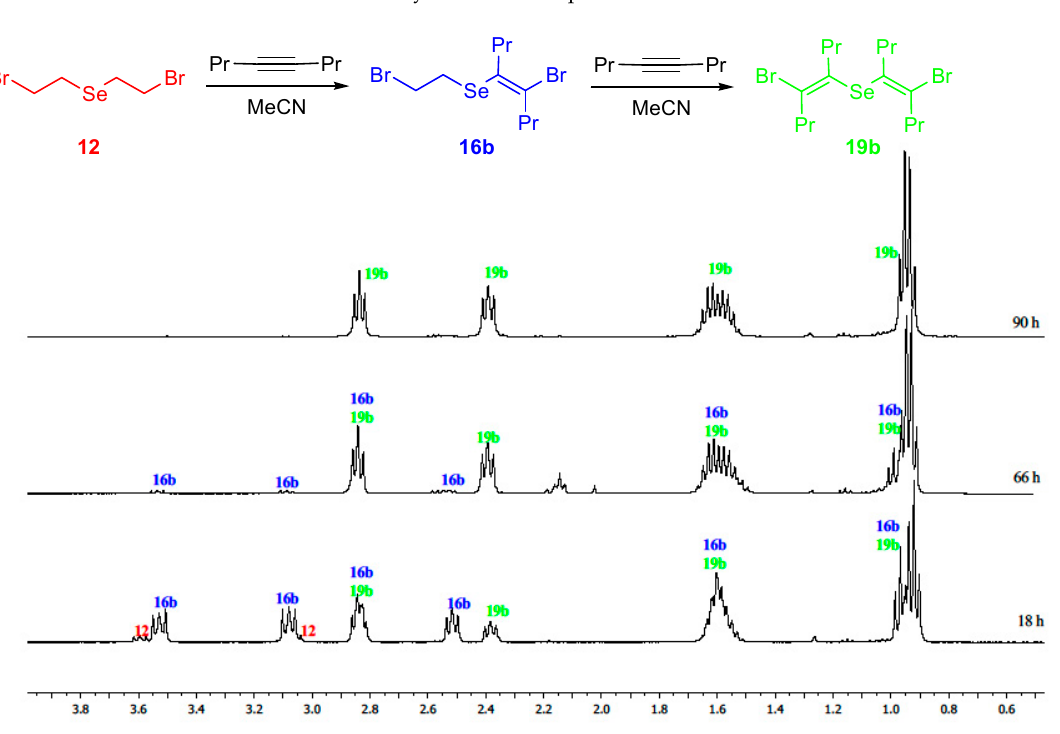
Figure 2. The 1 H-NMR monitoring of the 16b and 19b formation from selenide 12 in MeCN.